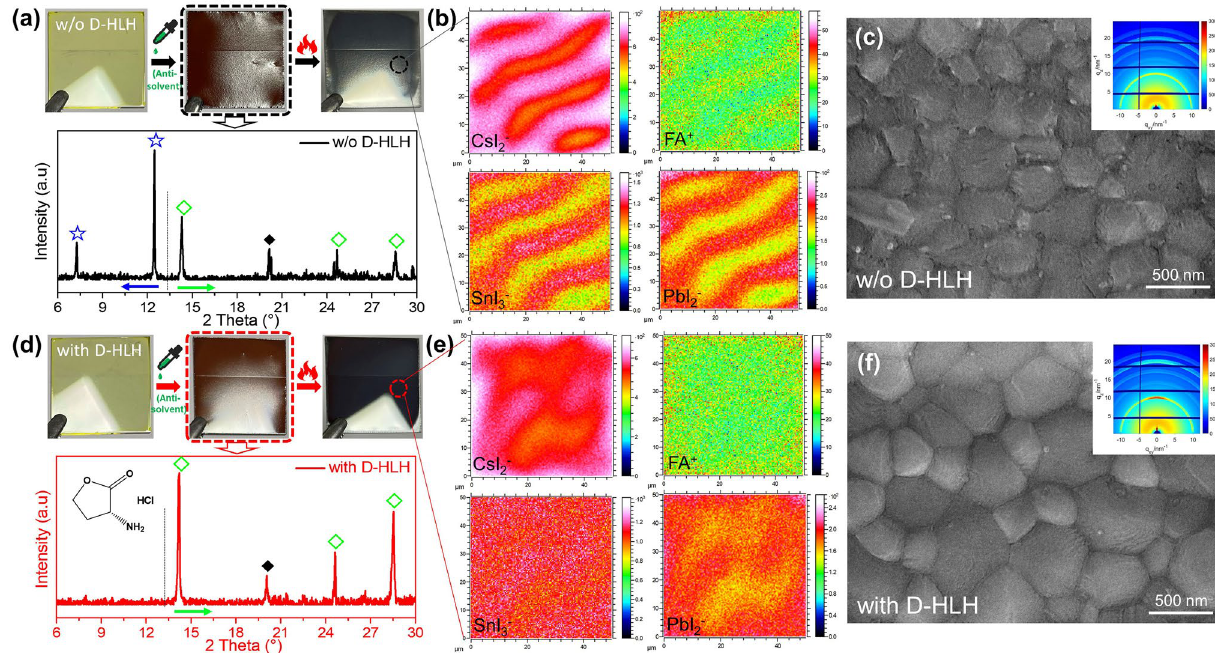
Fig. 1 a, d Photographs taken during the perovskite film fabrication process and XRD patterns of the intermediate phase films prepared a without or d with D‑HLH treatment (◆ represents ITO). b, e ToF–SIMS total depth profiles of the perovskites prepared b without and e with D‑HLH. c, f SEM images of perovskites prepared c without and f with D‑HLH; insets: GIWAXS images of the corresponding